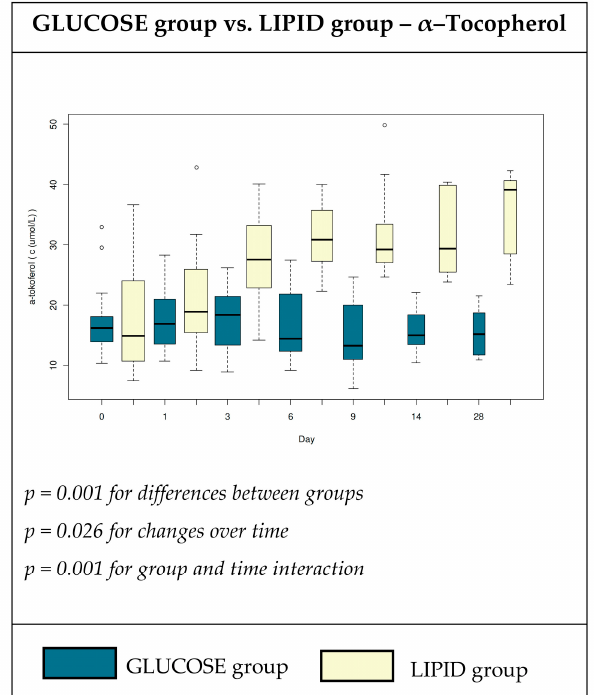
Figure 3. Plasma concentrations ( µ mol · L − 1 ) of a α -tocopherol in patients receiving high glucose; lipid-free (glucose group); or low glucose, high lipid (lipid group) TPN admixtures.